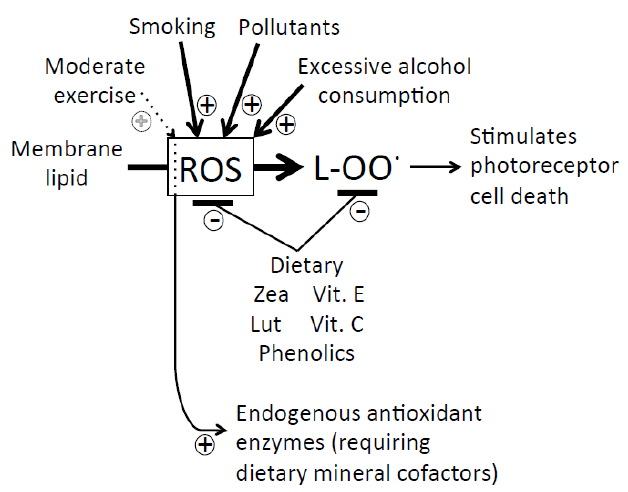
Figure 1. Schematic depiction of (1) the oxidation (by reactive oxygen species, ROS) of membrane lipids to lipid peroxides ( L -OO • ) that are further converted to messengers, e.g., stimulating photoreceptor cell death as well as (2) the effect of lifestyle/environmental/dietary factors on ROS and/or lipid peroxide levels. Moderate exercise generates moderate amounts of ROS serving to trigger full formation of endogenous antioxidant defenses (in the form of antioxidant enzymes requiring dietary minerals as their cofactors). Smoking, exposure to pollutants, and excessive alcohol consumption all strongly increase ROS levels. Dietary zeaxanthin (Zea), lutein (Lut), vitamins E (Vit. E) and C (Vit. C), and phenolics, as well as endogenous antioxidant enzymes, serve in synergy to lower the levels of ROS (via ROS detoxification) as well as recycle lipid peroxides (via re-reduction). Stimulation by ROS, and inhibition by various antioxidants, applies equally to non-enzymatic and enzymatic (via lipoxygenase, LOX) lipid peroxidation. Lipoxygenases contain a catalytic iron center that is active in lipid peroxidation only after oxidation (by ROS) to (active) LOX-Fe 3+ [53], and can be inactivated by antioxidants to (inactive) LOX-Fe 2+ [54]. Products of both enzymatic and non-enzymatic lipid peroxidation serve as gene